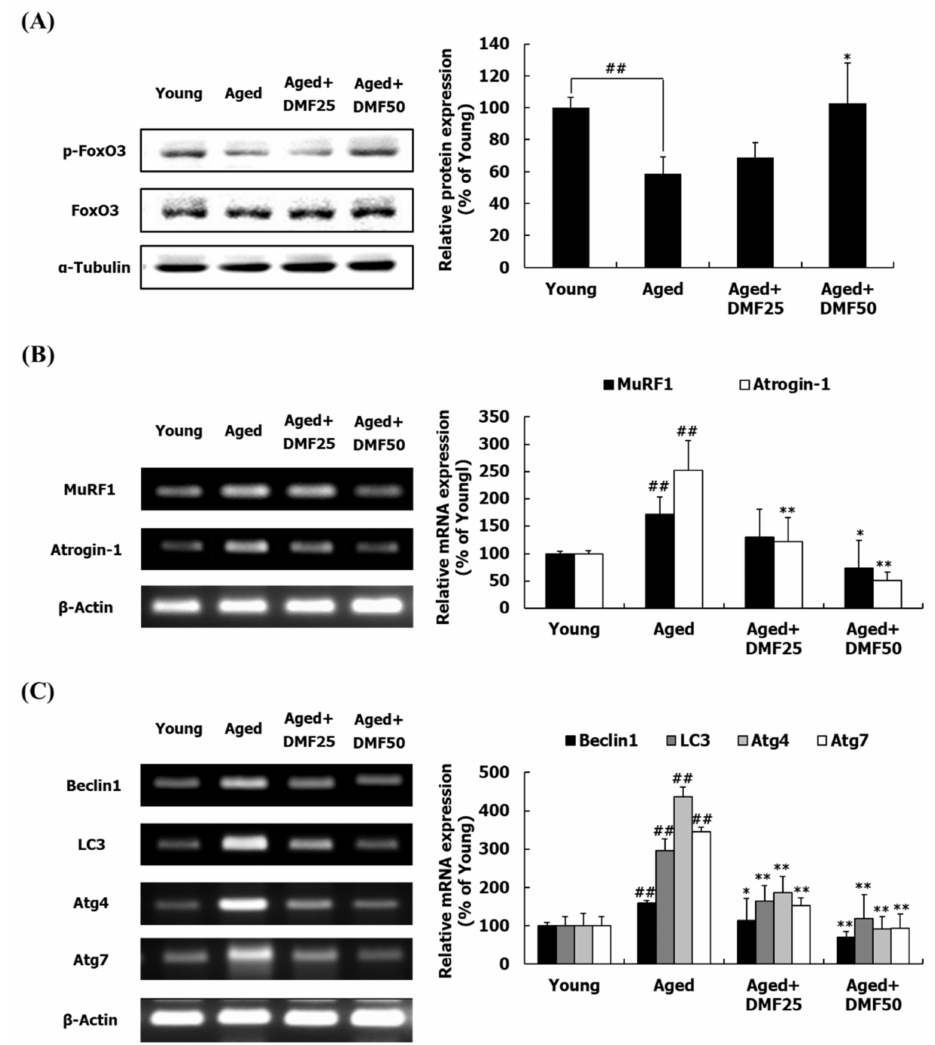
Figure 5. E ff ect of DMF on FoxO pathway in the gastrocnemius muscle. ( A ) Relative phosphorylation of FoxO. ( B ) Relative mRNA levels of MuRF1 and atrogin-1. ( C ) Relative mRNA levels of beclin1, LC3, Atg4, and Atg7. Results are presented as mean ± SD; ## p < 0.01 vs. Young group; * p < 0.05, ** p < 0.01 vs. Aged